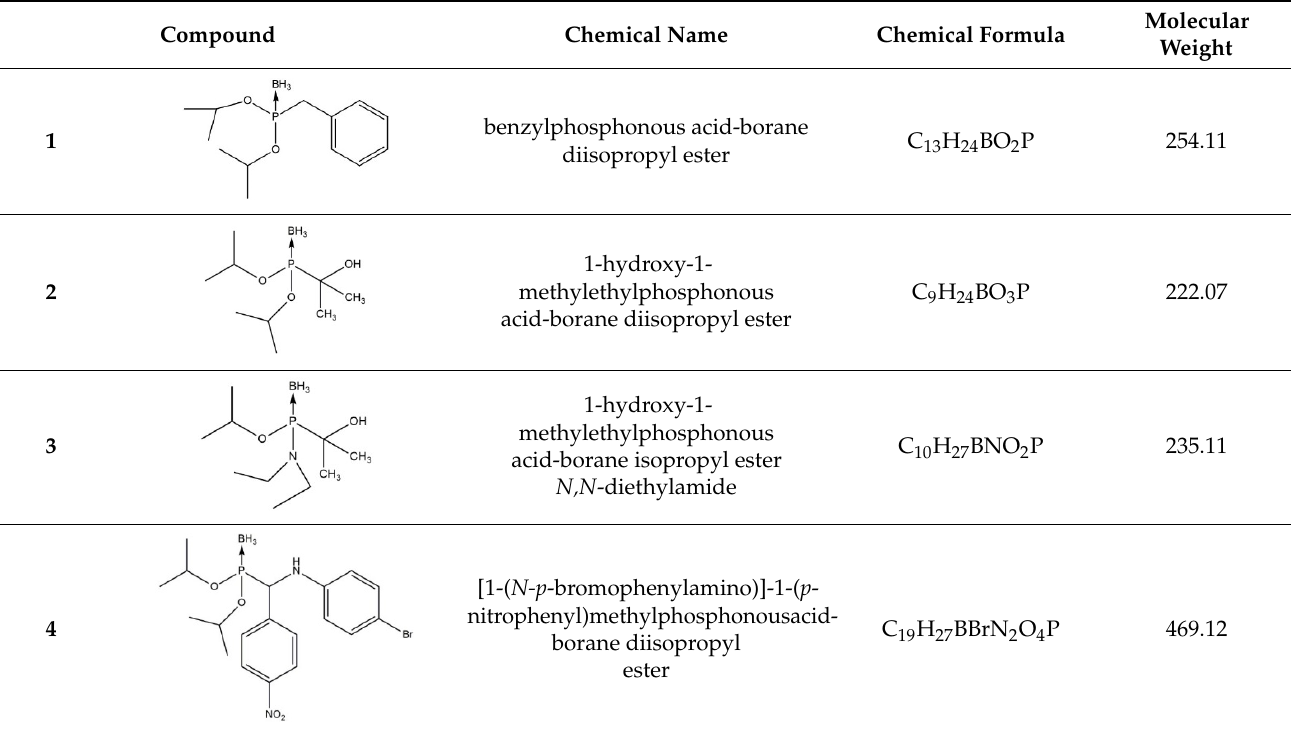
Table 1. Chemical structures, names, formulas and molecular weights of the new esters of phospho- nous acid-borane ( 1 ), α -hydroxyphosphonite-boranes ( 2 and 3 ), and α -amino phosphonite-boranes ( 4 , 5 , 6 , and 7 ).